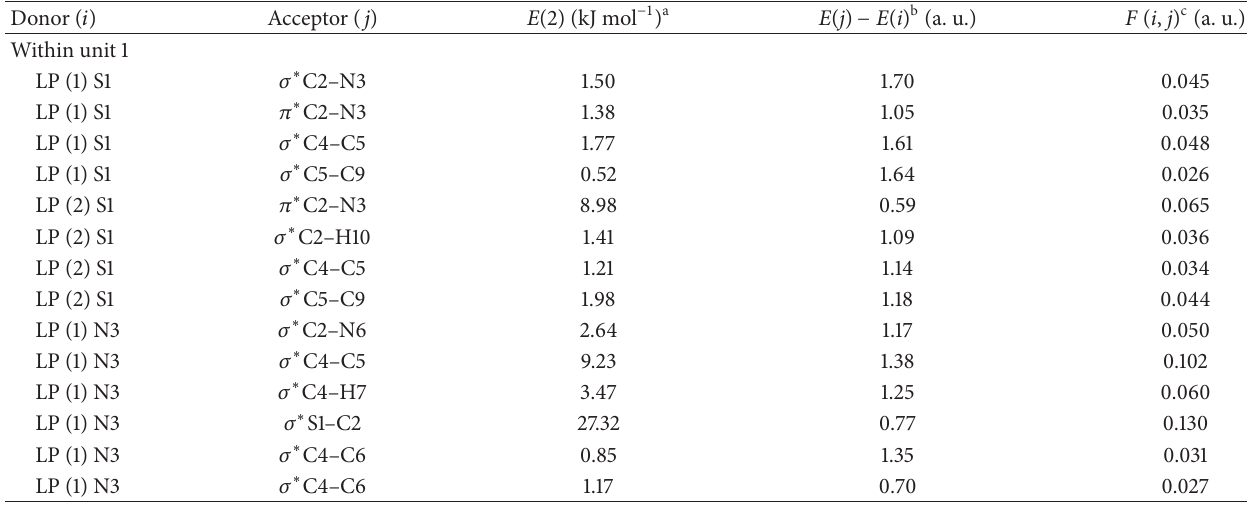
Table 5: Second-order perturbation energies 𝐸 (2) (donor → acceptor) for benzothiazole.